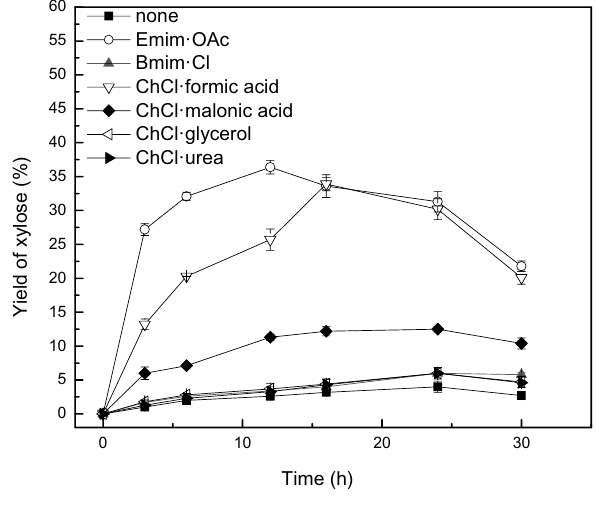
Fig. 3 Xylose yield from corn stover pretreated by different sol- vents. Reaction conditions: 0.05 g corn stover, 0.1 g solid acid cata- lyst and 4 mL deionized water, 363 K